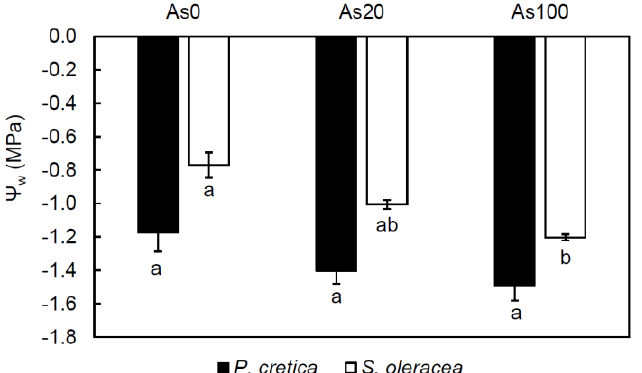
Figure 4. Effect of As treatments on the water potential (ψ w , MPa) of Pteris cretica and Spinacia oleracea in a pot experiment. Values represent the mean ± SE of three biological and two technical replicates per sample. Data with the same letter are not significantly different. Different letters indicate significant differences ( p ≤ 0.05) among treatments according to the Kruskal -Wallis test.